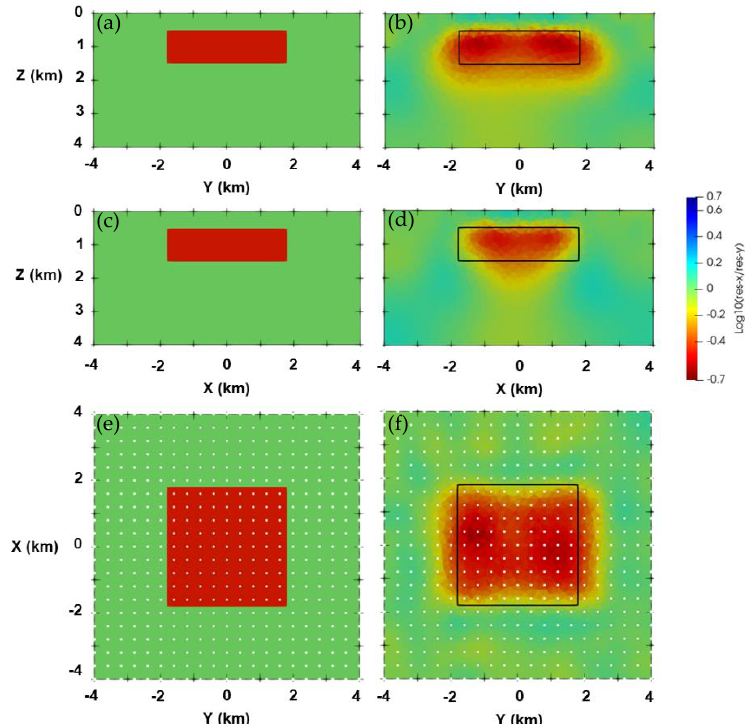
Figure 8. The inverted anisotropic coefficient. Panels ( a ) and ( b ) show the true model and the recovered model at x = 0 km. Panels ( c ) and ( d ) show the true model and the recovered model at y = 0 km. Panels ( e ) and ( f ) show the true model and the recovered model at z = 1 km.